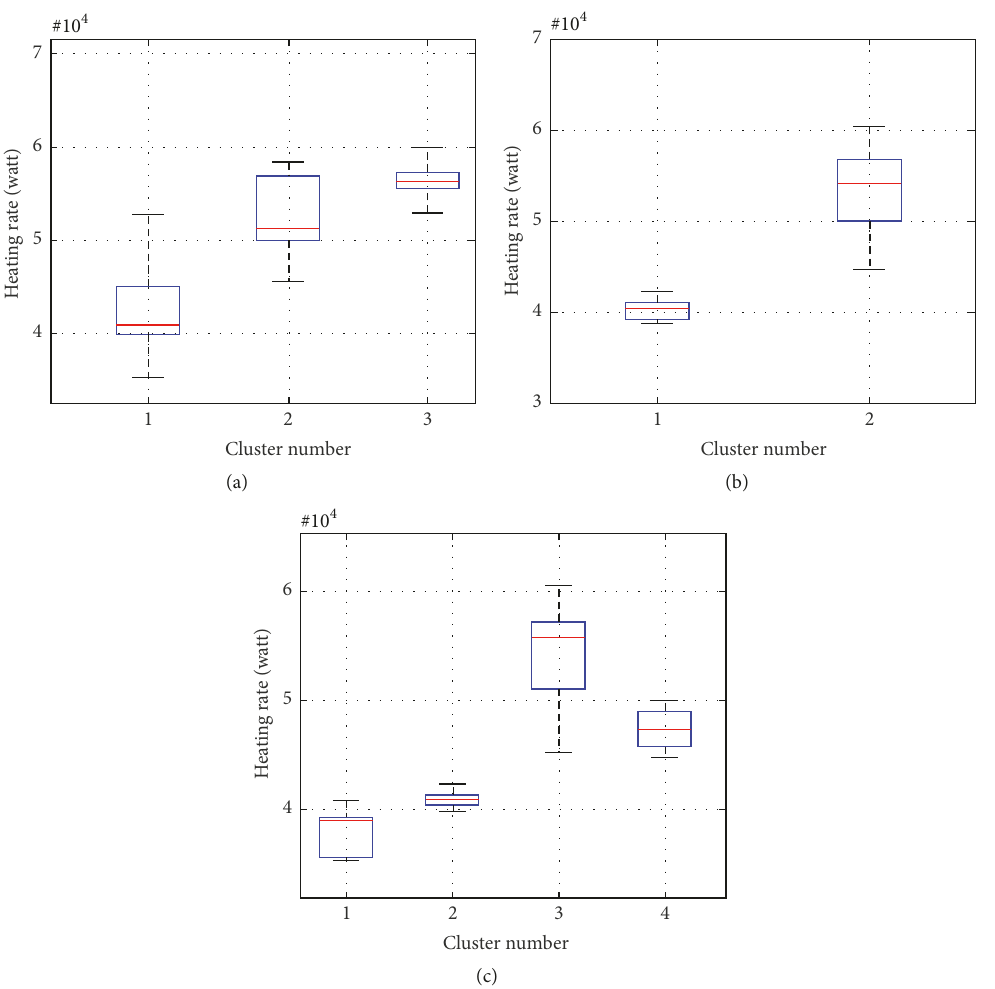
Figure 12: Average heating rate caused by west zone’s thermal load for each discrete mode (in watt) estimated by (a) 𝐾 -means algorithm, (b) GMM algorithm, and (c) hierarchical algorithm.